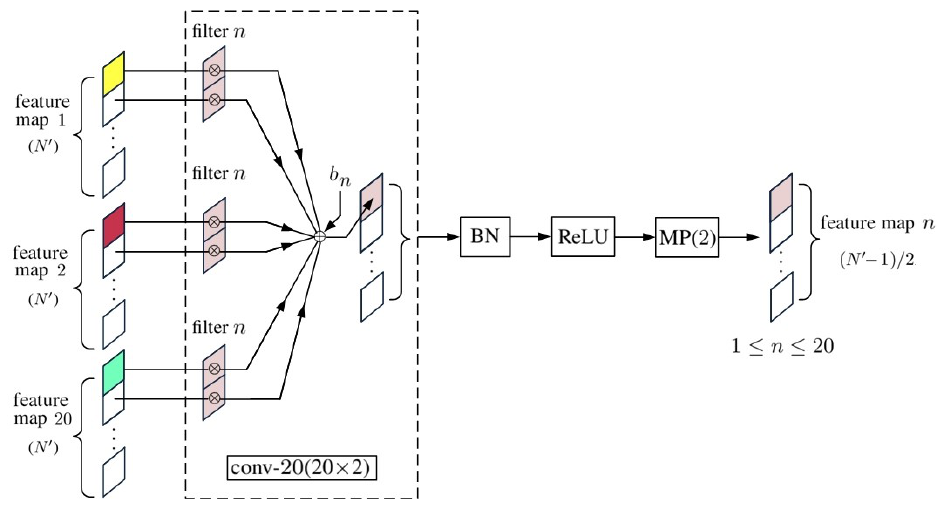
Figure 4. Schematic of convp-20 ( 20 × 2 ) .